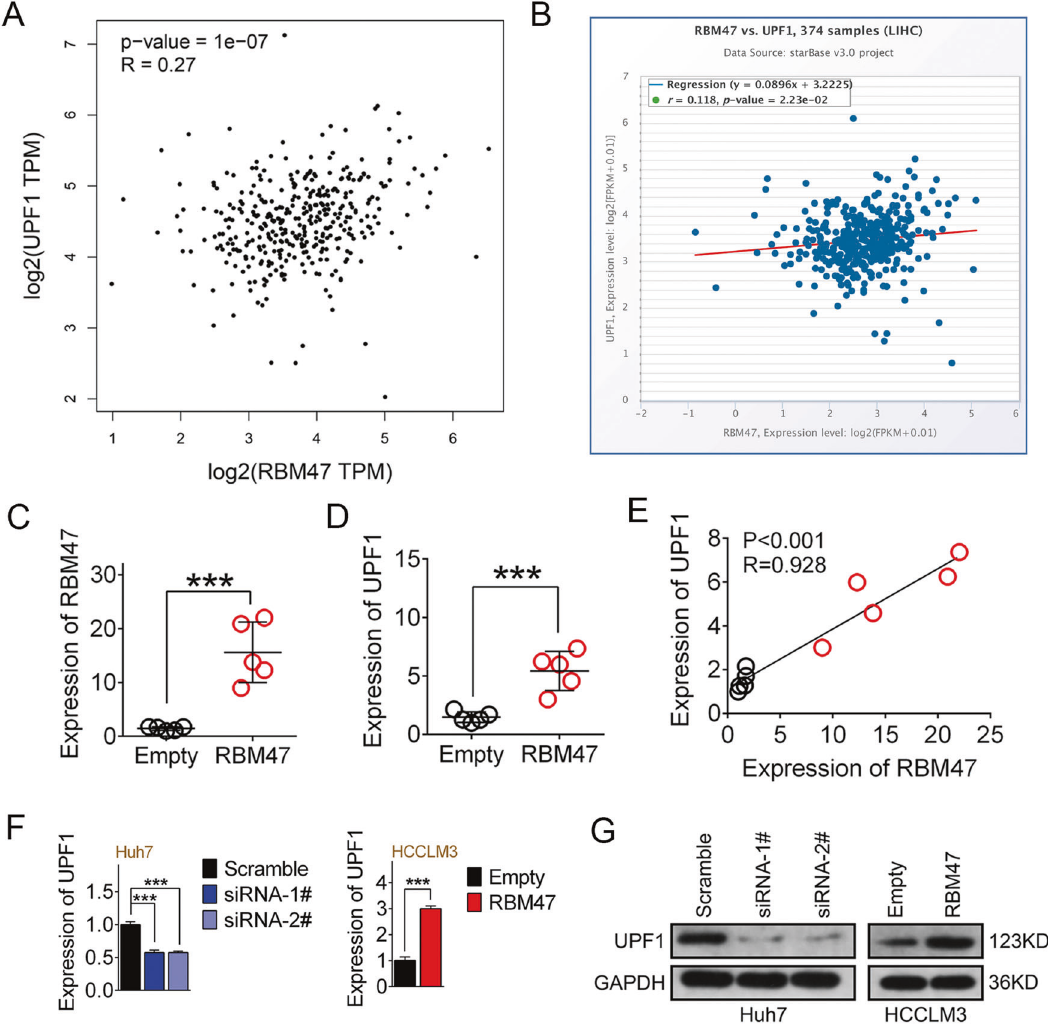
Fig. 4 RBM47 upregulates UPF1 in HCC. A Bivariate correlation analysis of the relationship between RBM47 and UPF1 in HCC tissues in the GEPIA database. B A positive correlation between RBM47 and UPF1 was determined in 374 HCC tissues in starBase database. C – E RBM47 expression, UPF1 expression, and their correlation of subcutaneously implanted tumors between the RBM47 overexpression group and the control group. Red dots represent the RBM47 overexpression group, and black dots represent the control group. Error bars are SD ( n = 5). F , G qRT-PCR and western blot analysis of the expression of UPF1 after RBM47 knockdown in Huh7 cells and overexpression in HCCLM3 cells. *** P <